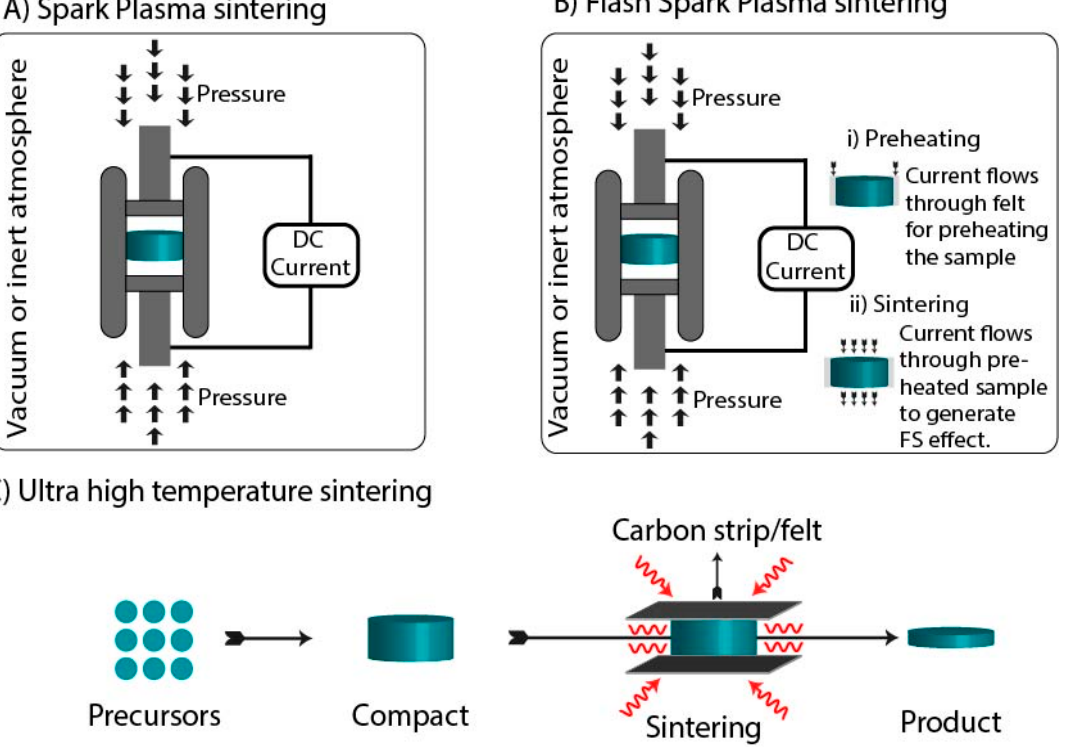
Figure 3. Schematic representation of ( A ) Spark Plasma sintering, ( B ) Flash spark plasma sintering, and ( C ) Ultrafast high-temperature sintering.